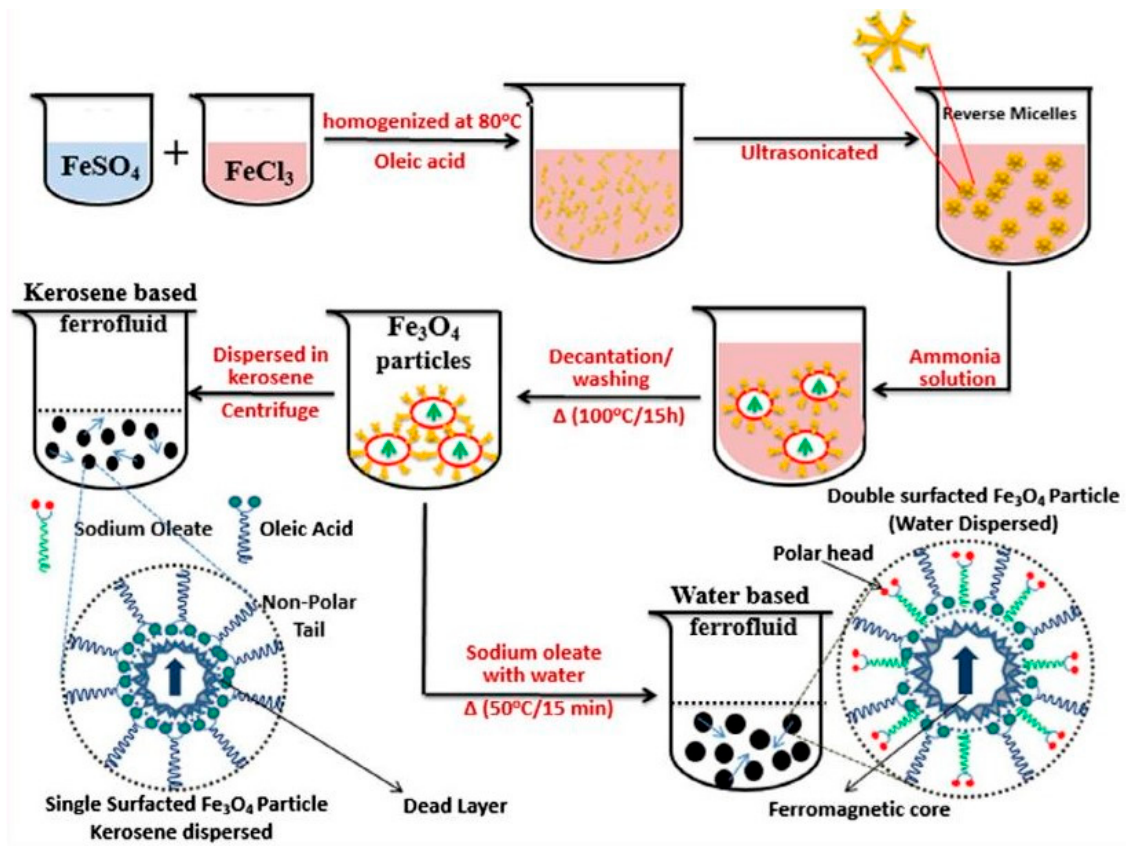
Figure 10. Schematic representation of the aqueous and kerosene-based magnetic fluid preparation by dispersing double surfactant (oleic acid (blue string) and sodium oleate (green string)) Fe 3 O 4 MNPs using the two-step wet chemical synthesis method (adapted from [90] with permission from Elsevier, 2019).